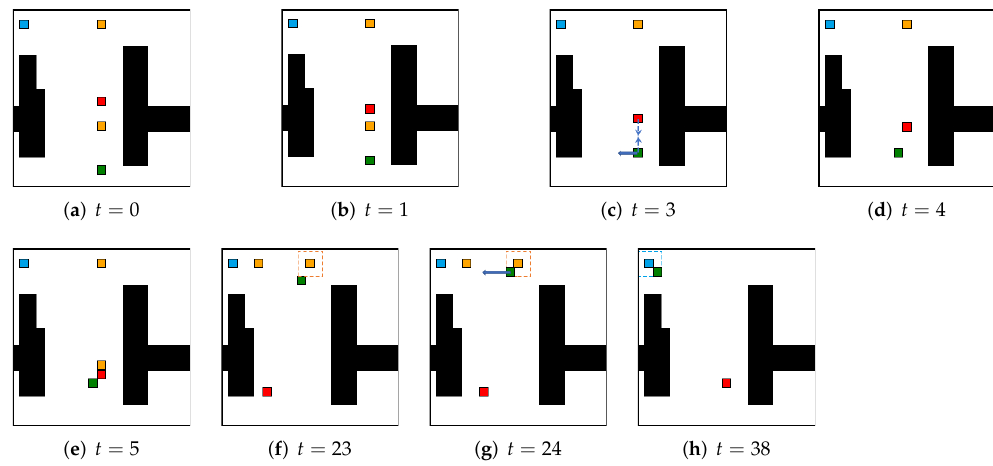
Figure 12. The trajectory of the agent under the condition of k 1 = 1, k 2 = 1 set in f .